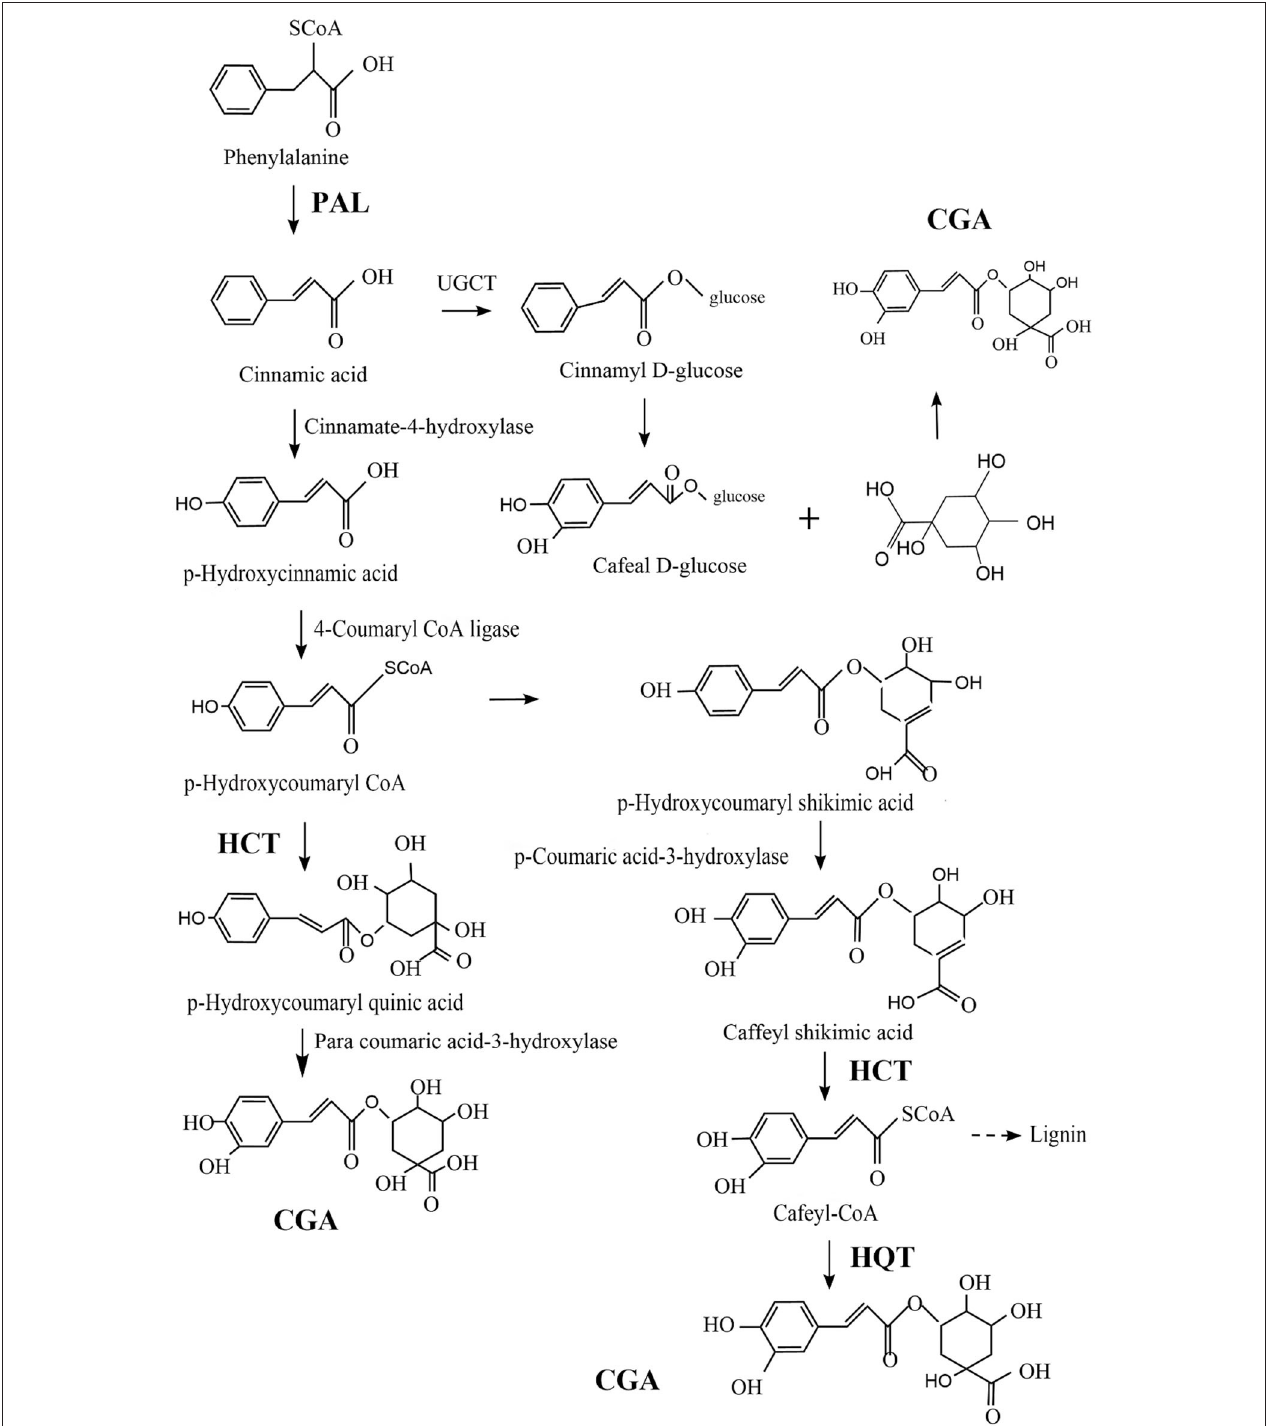
FIGURE 3 | Three possible pathways of CGA synthesis.